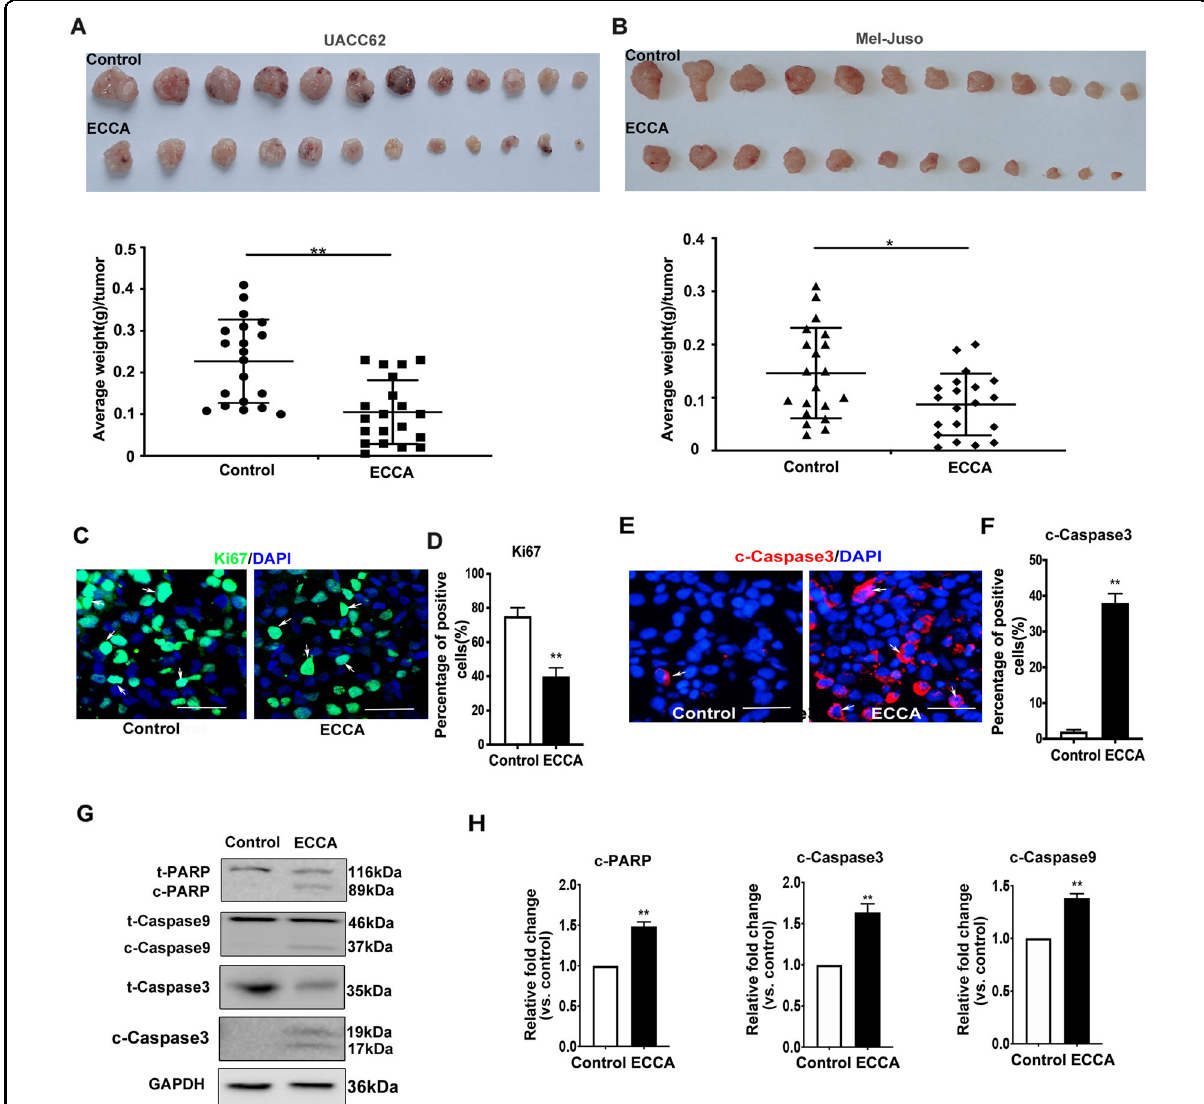
Fig. 3 ECCA suppresses melanoma tumor growth in vivo. A, B Upper. Representative images of tumors from mice (shown in Fig. S2A, B) taken 3 weeks after xenografting UACC62 A and Mel-Juso B cells combined with the intraperitoneal injection of ECCA or PBS (control). Lower, quanti fi cation of the average weight of tumors. C Representative images of immuno fl uorescence staining to detect Ki67 (green) expression in subcutaneous tumor sections. DAPI (blue) staining identi fi es nuclei. White arrows indicate Ki67-positive cells. Scale bars indicate 100 μ m. D Quanti fi cation of Ki67-positive cell percentage (%) of a total of 500 DAPI-positive cells in C . E Representative images of immuno fl uorescence staining to detect cleaved-Caspase3 (red) expression in subcutaneous tumor sections. DAPI (blue) staining identi fi es nuclei. White arrows indicate cleaved-Caspase3-positive cells. Scale bars indicate 100 μ m. F Quanti fi cation of cleaved-Caspase3-positive cell percentage (%) of a total of 500 DAPI- positive cells in E . G Immunoblotting analysis of total and cleaved forms of PARP, Caspase9, and Caspase3 in tumors treated with PBS (control) or with ECCA. GAPDH is a housekeeping gene used as a loading control. H Quanti fi cation of the relative levels of c-PARP, c-Caspase9, and c-Caspase3 in G , as relative fold change to the respective control cells, after each cleaved protein was normalized to the corresponding total protein band. All experiments were carried out three times, and error bars represent means + SD; P values are indicated with “ * ” , * indicates P < 0.05, ** indicates P < 0.01 when comparing the ECCA-treated group with the control group in A , B , D , F , and H by Student ’ s t